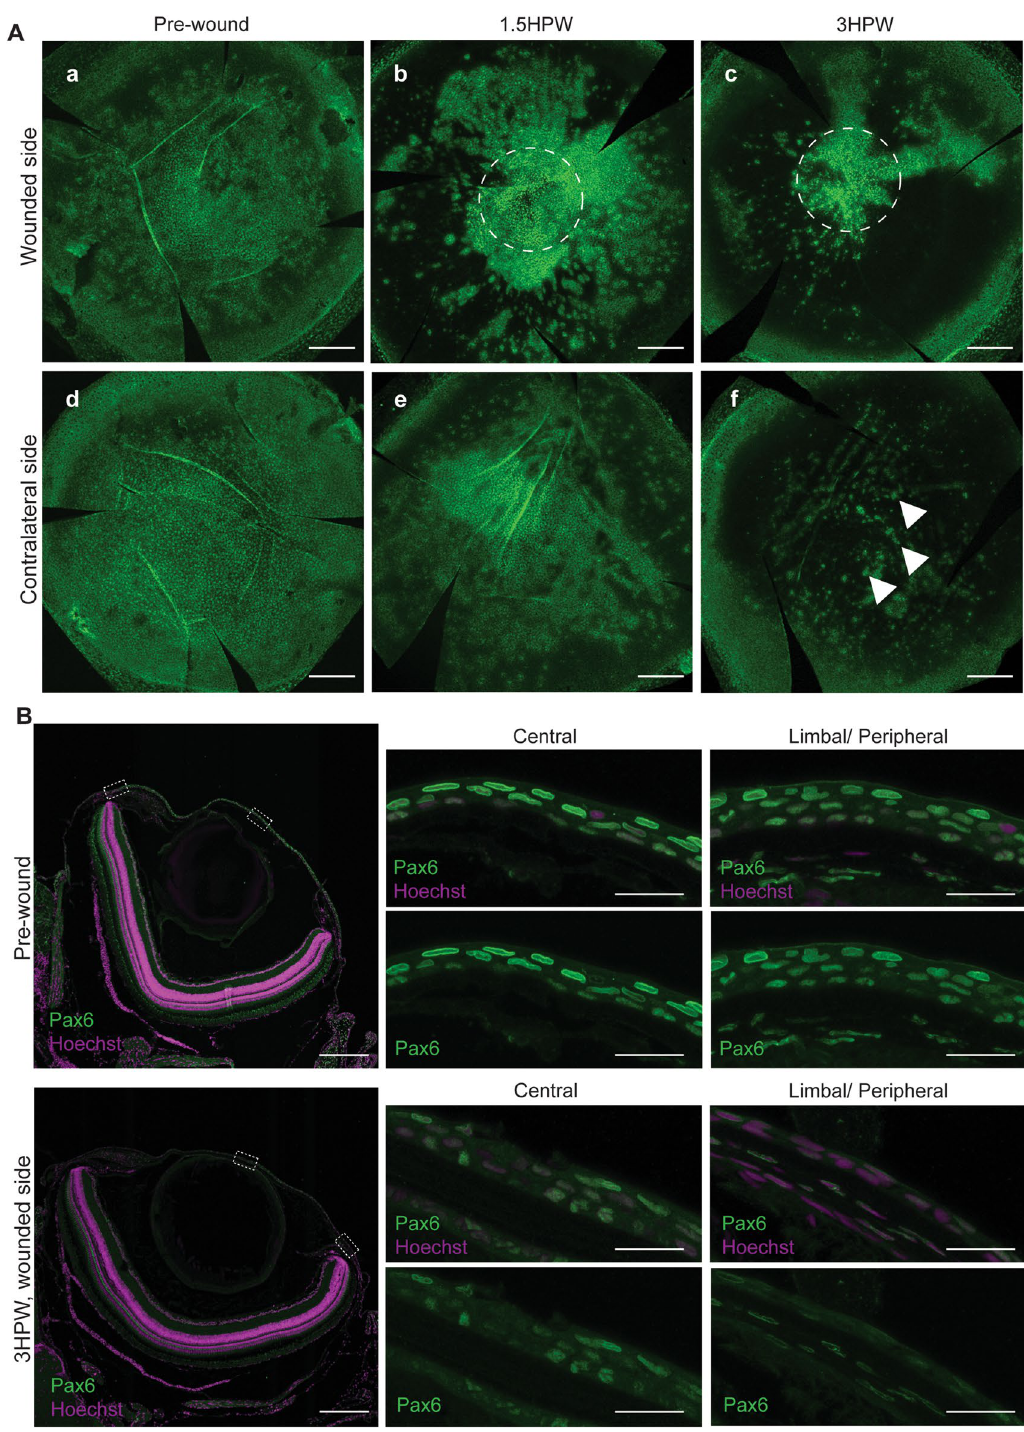
Figure 11. PAX6 immunological detection during wound closure. ( A ) Whole-mount staining showing an overview of Pax6 signal before wounding, and 1.5 or 3HPW, shows the disappearance of Pax6 in areas distant to the wound and a reinforcement closer to the wound site, on the wounded side (a–c). Dashed lines indicate wound location. On the contralateral side (d–f), Pax6 remains only in specific site, leading to a punctated pattern. ( B ) Immunofluorescence on sections showing Pax6 signal together with Hoechst nuclear counterstaining, before or 3HPW (wounded side) in central or peripheral cornea (boxed areas in whole-eye images), confirms the global loss of Pax6. HPW: hours post-wound. Maximum intensity projection of the whole cornea or 5-µm section, scale bars: 300 µm in A, 200 and 20 µm in B. HPW: hours